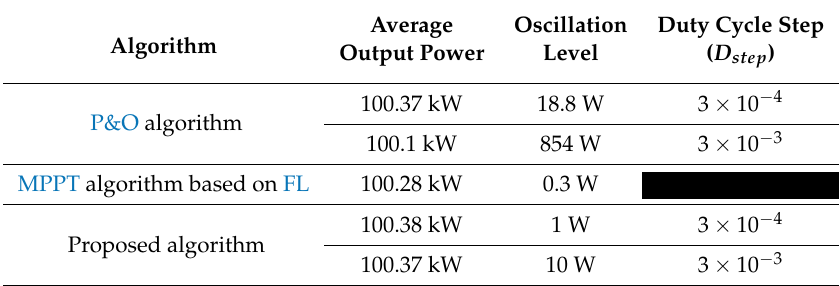
Table 3. Average output power and oscillation power around the MPP under stable radiance at 1000 W/m 2